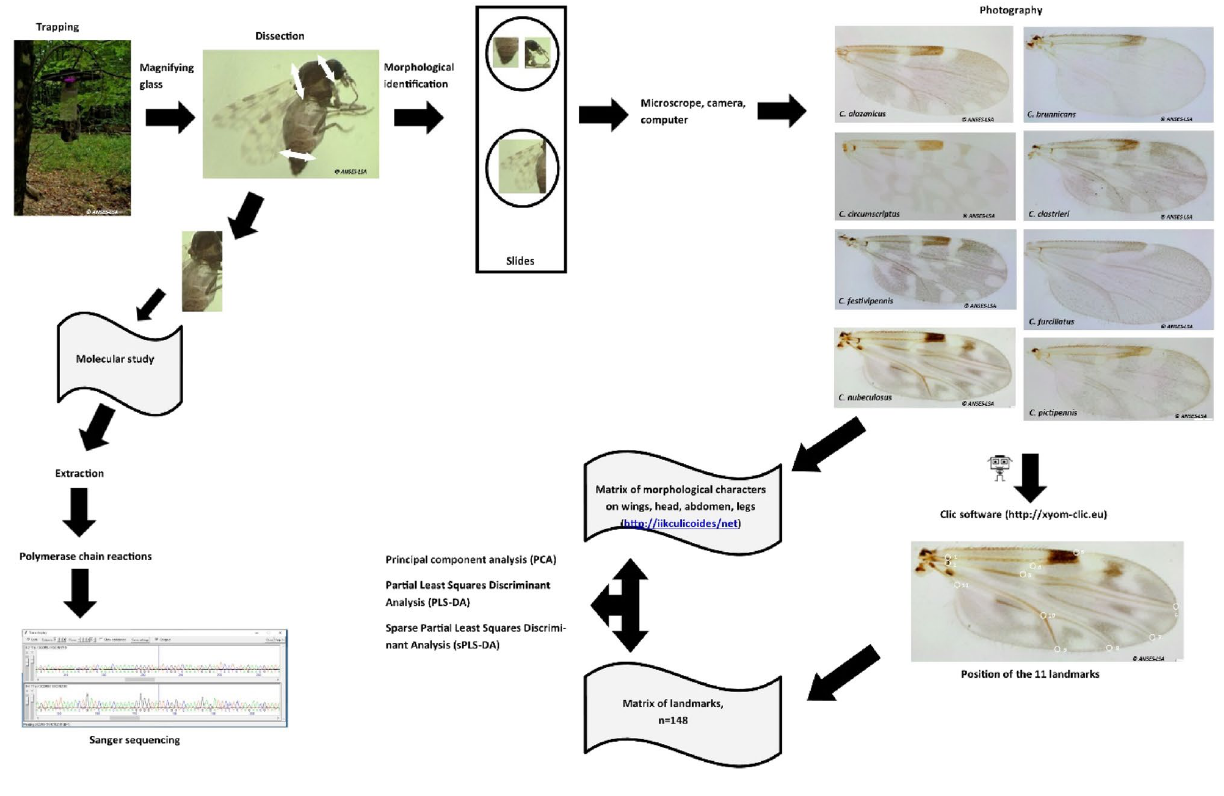
Figure 1. Block diagram of the